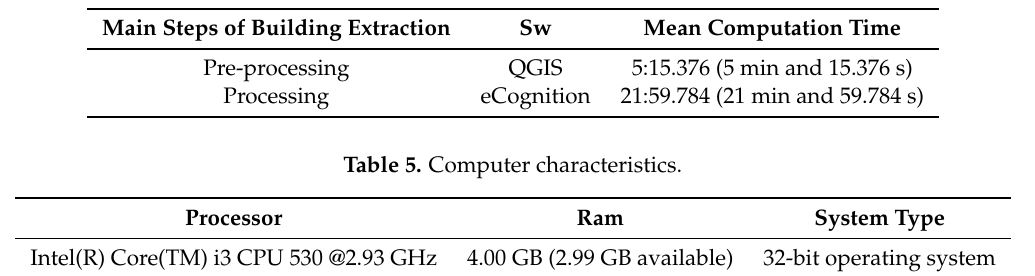
Table 4. Computational cost.